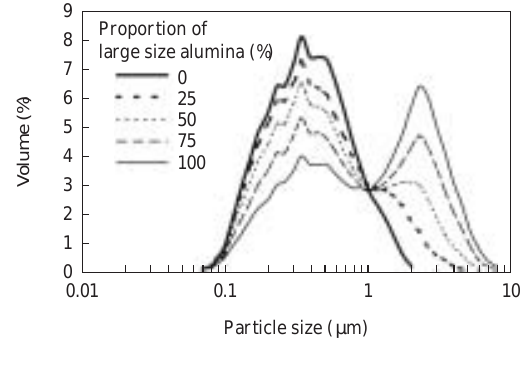
Particle size distribution as a function of particle size blended powder